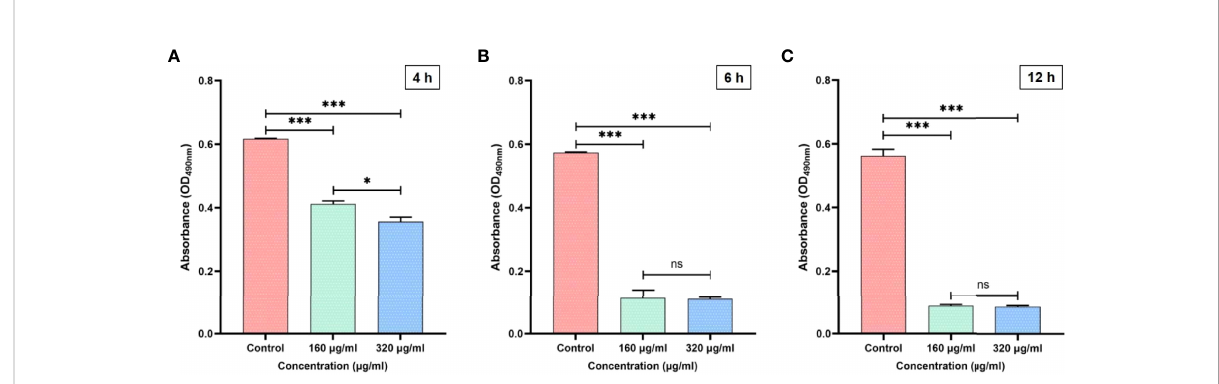
concentration reached 160 and 320 m g/mL, the fl uorescence intensity decreased by 39.22% and 49.45%, respectively, in comparison with the control group. Furthermore, the b -glucan quantitative detection assay showed that C. albicans cell wall b - glucan content decreased signi fi cantly after drug action, and the inhibitory effects were concentration-dependent ( P <